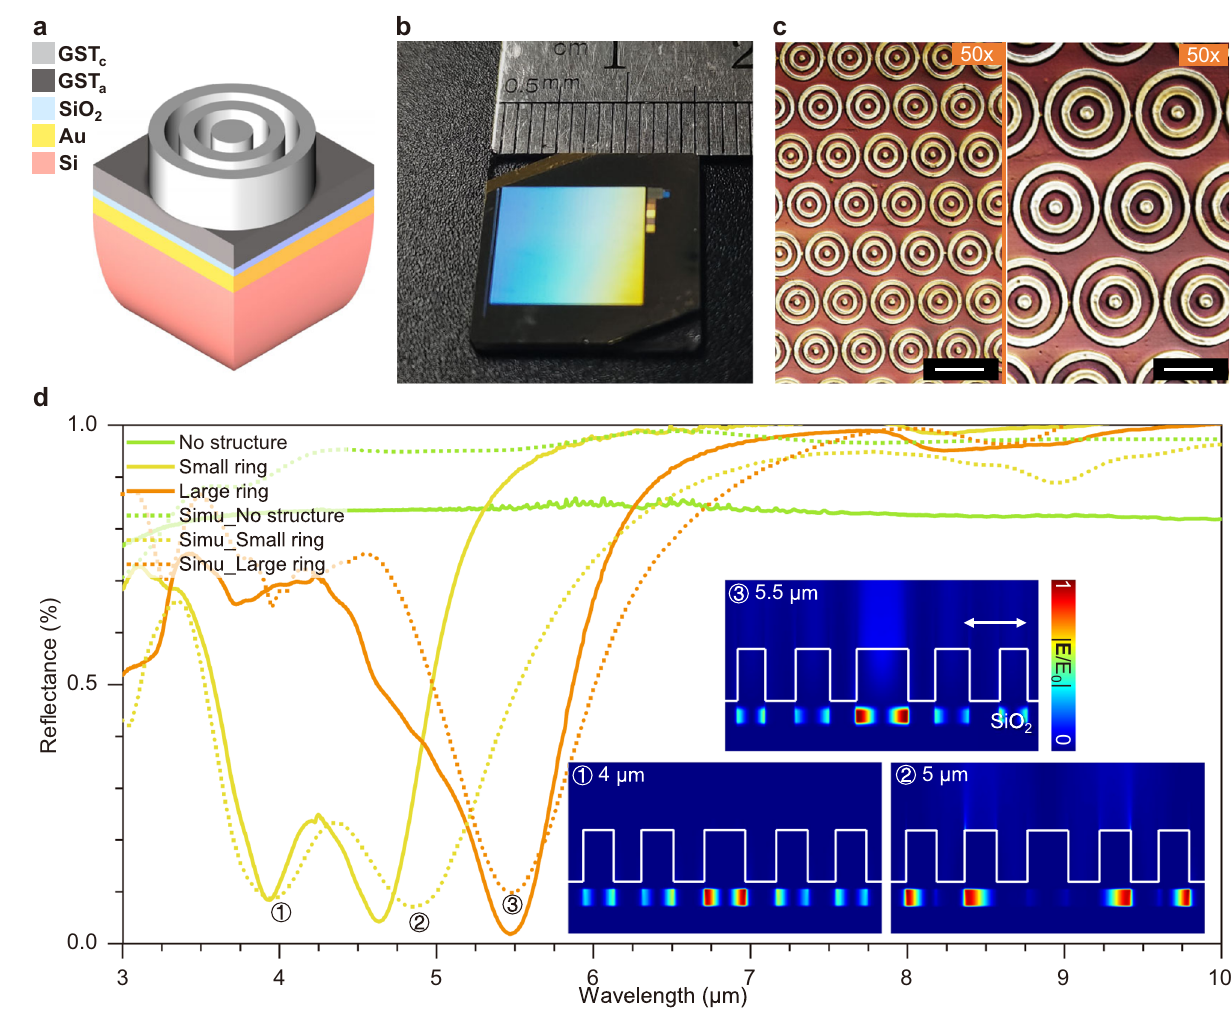
Fig. 6 | The application of concentric rings in metasurface as a mid-infrared absorber.a Schematicofthedesignedstructurefortheabsorber. b Photographof the large-area metasurface with concentric rings as structural units. c Surface morphology of small (left) and large (right) concentric rings produced by 50× objective. Scale bars: 10 μ m. d The re fl ectance spectrum for the experimental